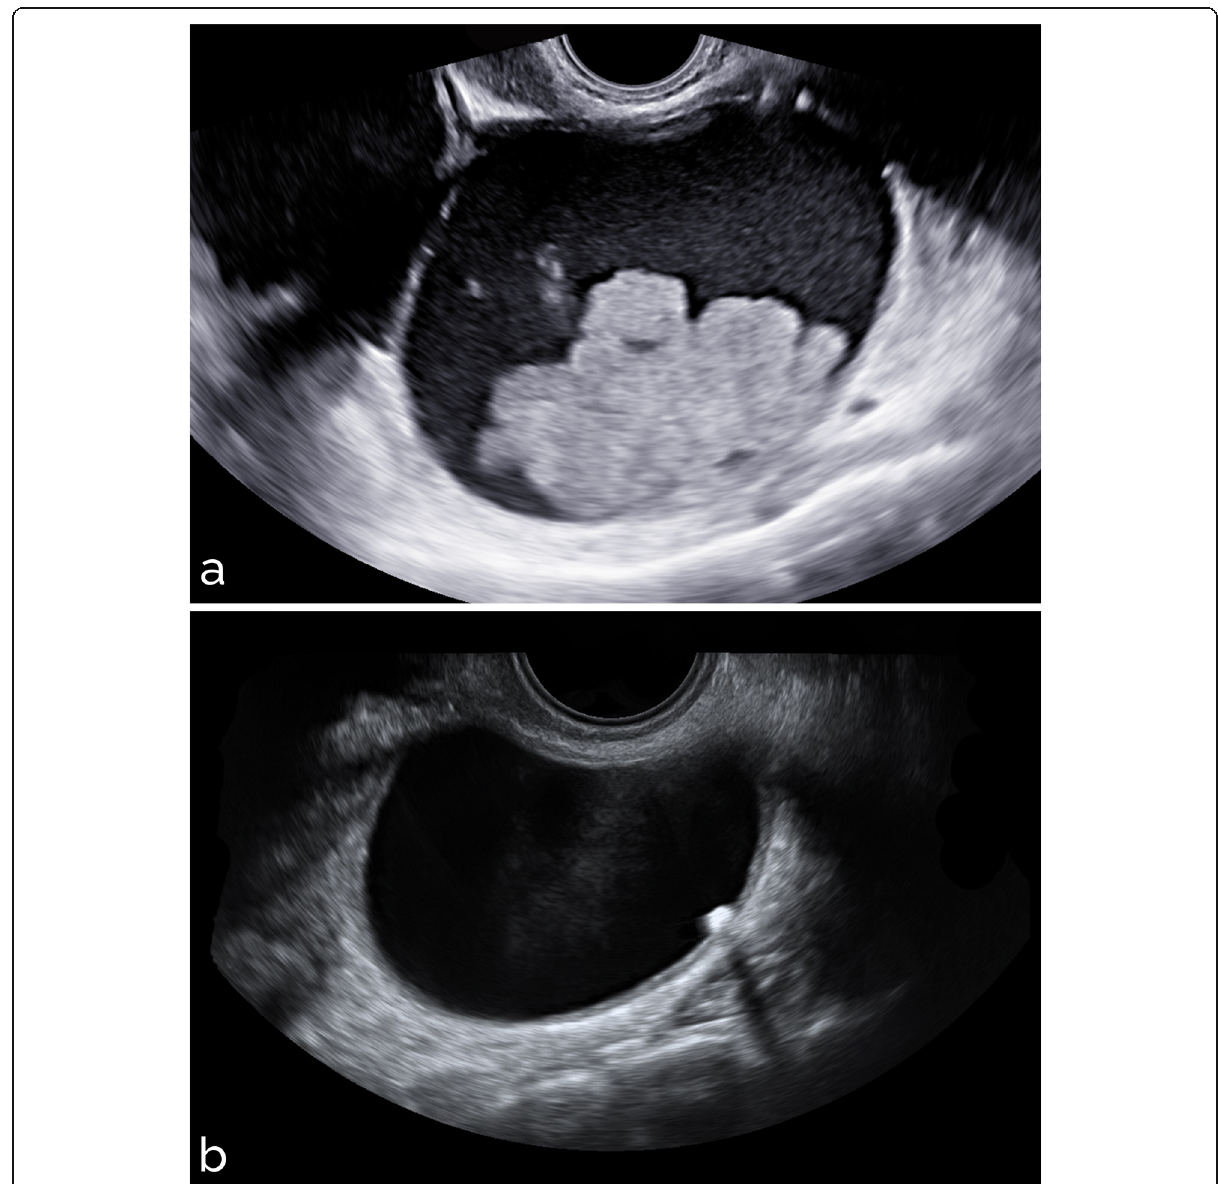
Fig. 9 Transvaginal ultrasound of mixed ovarian masses: ( a ) serous borderline tumour on histological examination (medium-high risk), ( b ) cystoadenofibroma on histological examination (very low